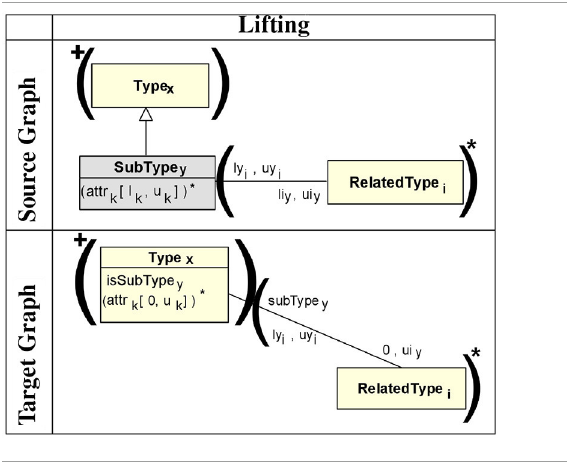
TABLE 2 The lifting operation.